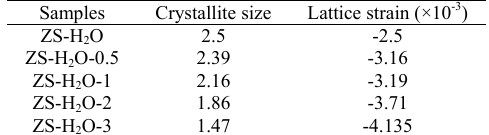
Table 1. Amounts of lattice properties obtained from XRD patterns 1. Amounts of lattice properties obtained from XRD patterns.